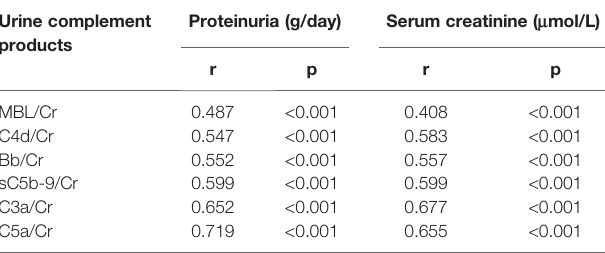
TABLE 2 | Association of urinary activated complement products and baseline characteristics in patients with IgA nephropathy. Urine complement